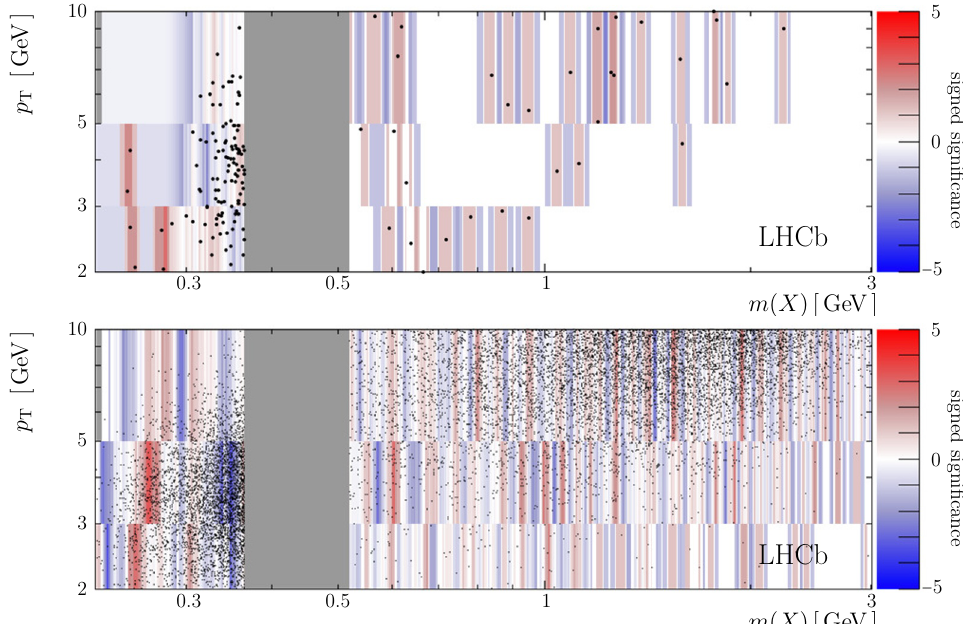
Figure 6 . Signed local signi(cid:12)cances for the (top) promptly produced and (bottom) inclusive searches for displaced X (cid:22) + (cid:22) (cid:0) decays. The black points show the individual candidates. ! the background in this region, and due to the small bin occupancies, the background is estimated by interpolating the yields in the sidebands starting at 3 (cid:27) [ m ( (cid:22) + (cid:22) (cid:0) )] from (cid:6) m ( X ). The statistical test at each mass is based on the pro(cid:12)le likelihood ratio of